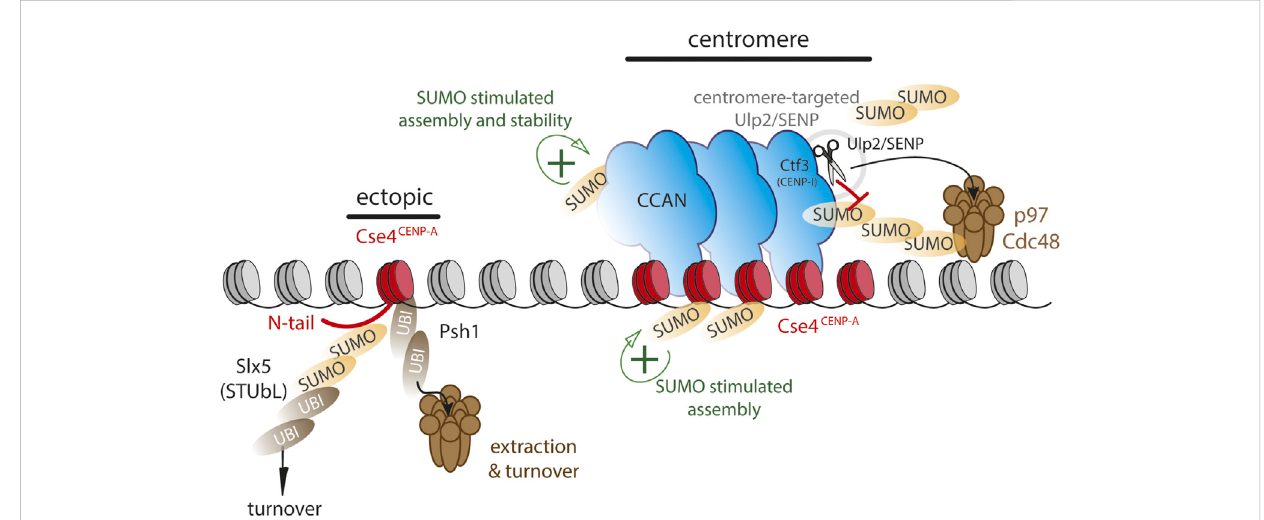
FIGURE 2 SUMO and ubiquitin dynamics may differentially control CENP-A chromatin stability at centromeres versus non-centromeric loci. Model largely basedonevidencefrombuddingyeast.FunctionalSUMOatcentromeres(green+)iskeptatalowlevelbytargetingUlp2/SENPtocentromeresviaCENP- I/Ctf3, thereby stabilizing the centromere complex. Assembly of CENP-A/Cse4 is stimulated by C-terminal SUMO. Ectopic loci are vulnerable to polySUMOylation as well as SUMO-dependent ubiquitylation via Slx5 on Cse4 N-terminus or directly via Psh1 ubiquitin ligase, targeting CENP-A/ Cse4 to Cdc48/p97 segregase for chromatin